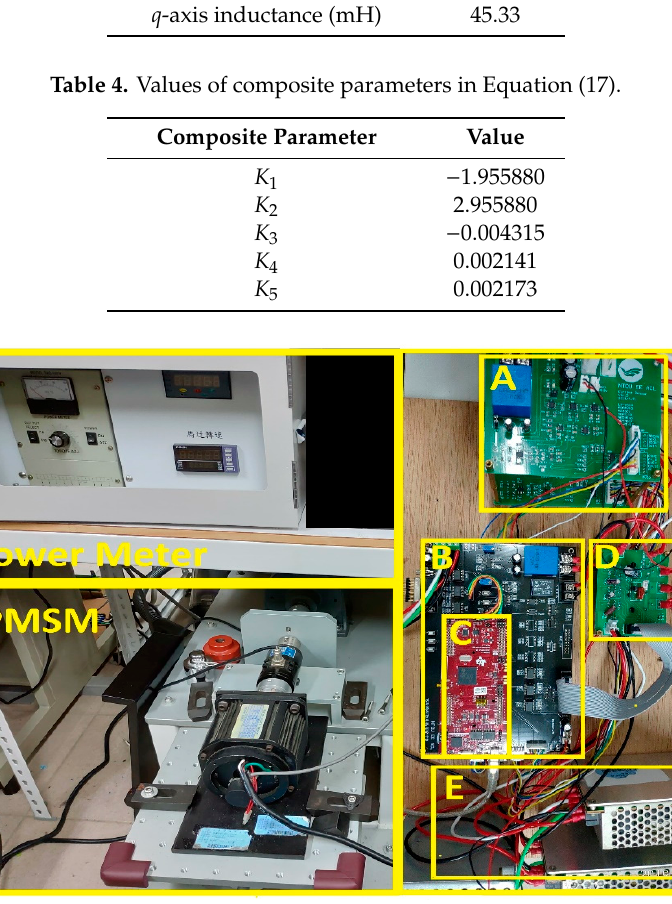
Figure 7. Drive circuit of the MMPCC.